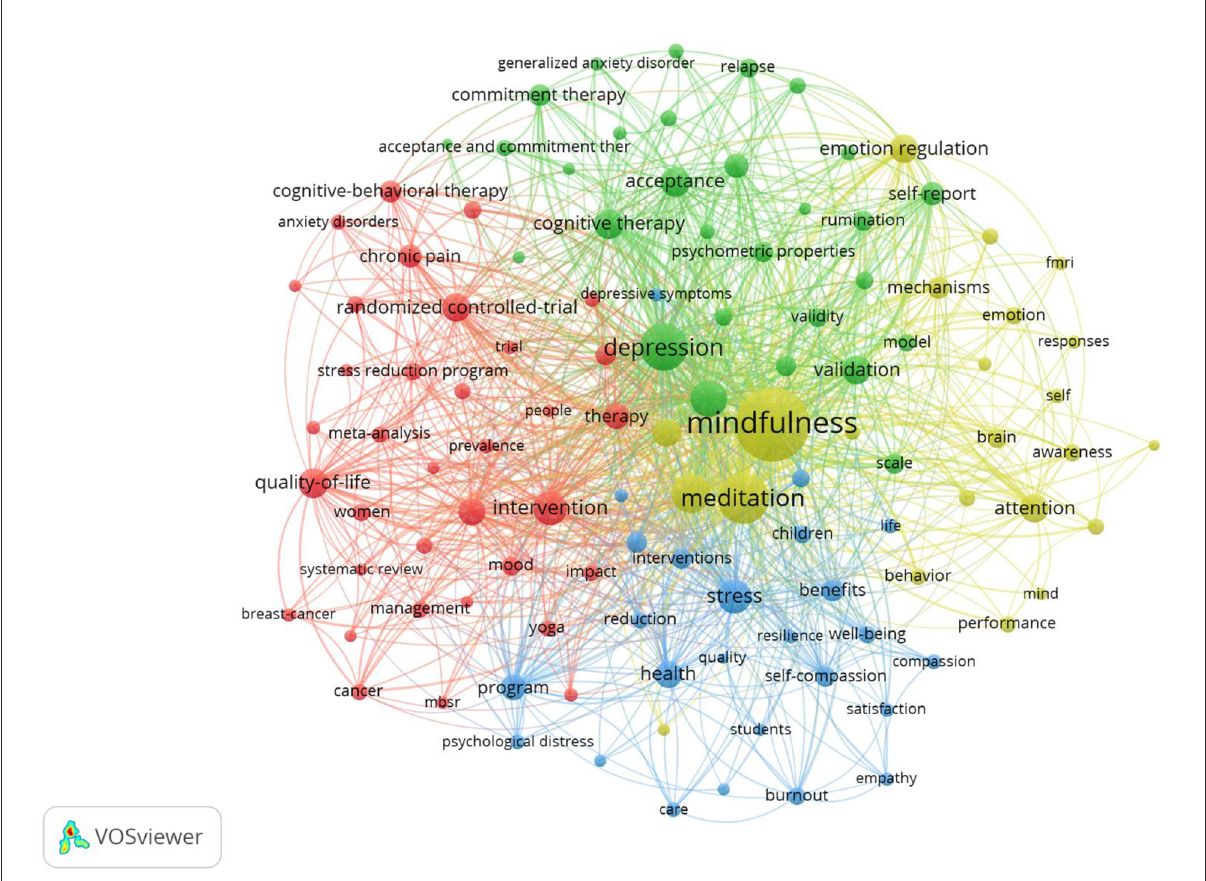
FIGURE3 Network visualization of co-word